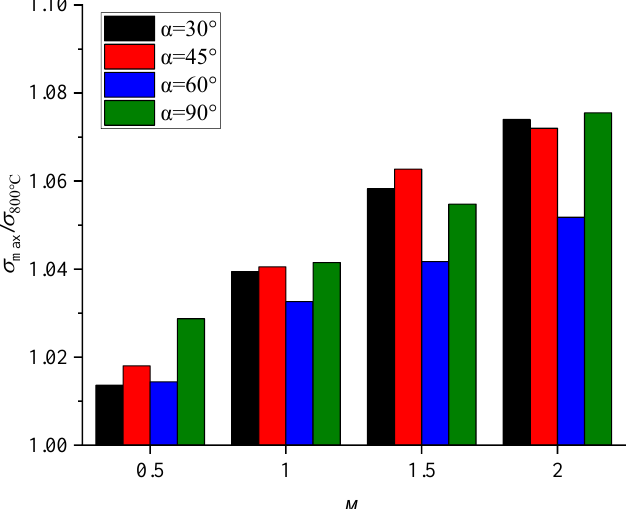
Figure 25. Ratios of maximum thermomechanical stress of research film hole to the stress under 800 °C for all cases.